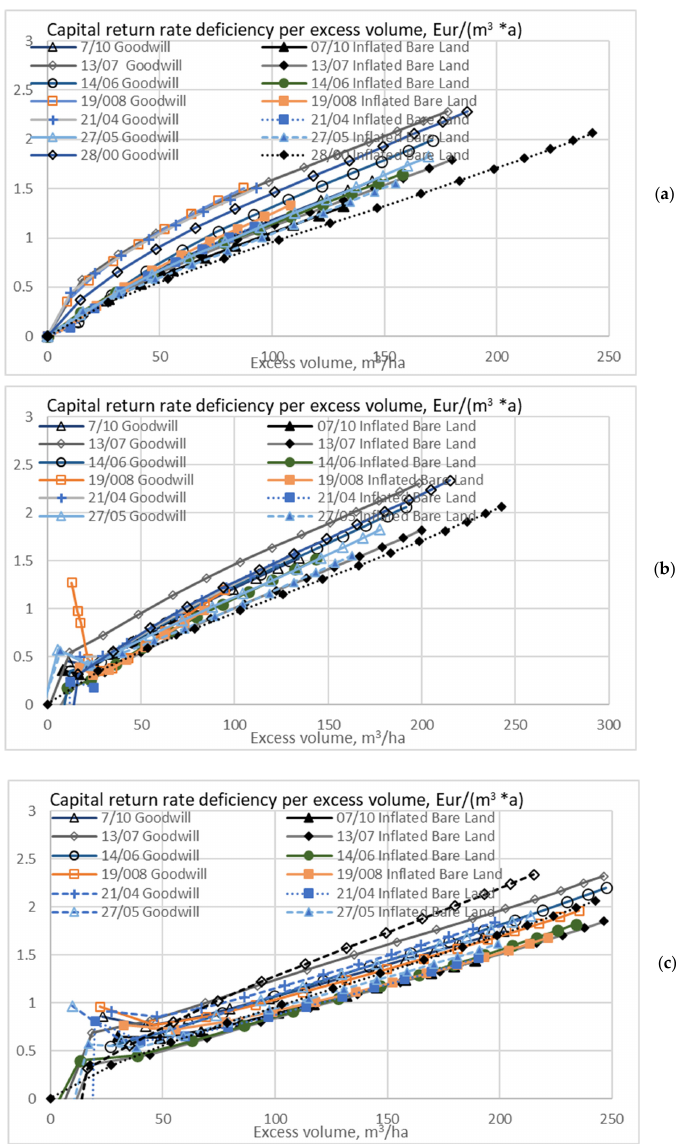
Figure 12. The expected value of capital return rate deficiency per excess volume unit, as a function of excess volume, when the growth model is applied to seven observed wooded stands, without any thinning restriction ( a ), in good-quality trees of at least 238 mm of diameter only removed in thinning ( b ), and without any commercial thinning ( c ). Inflated capitalization is introduced either as proportional goodwill or as inflated bare land value; the numbers in legends identify stands and observation plots.